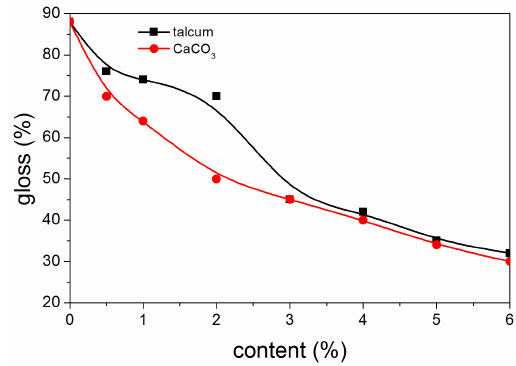
Figure 10. Effect of single filler on gloss of coating (sample 5, 11–24 in Table 1).